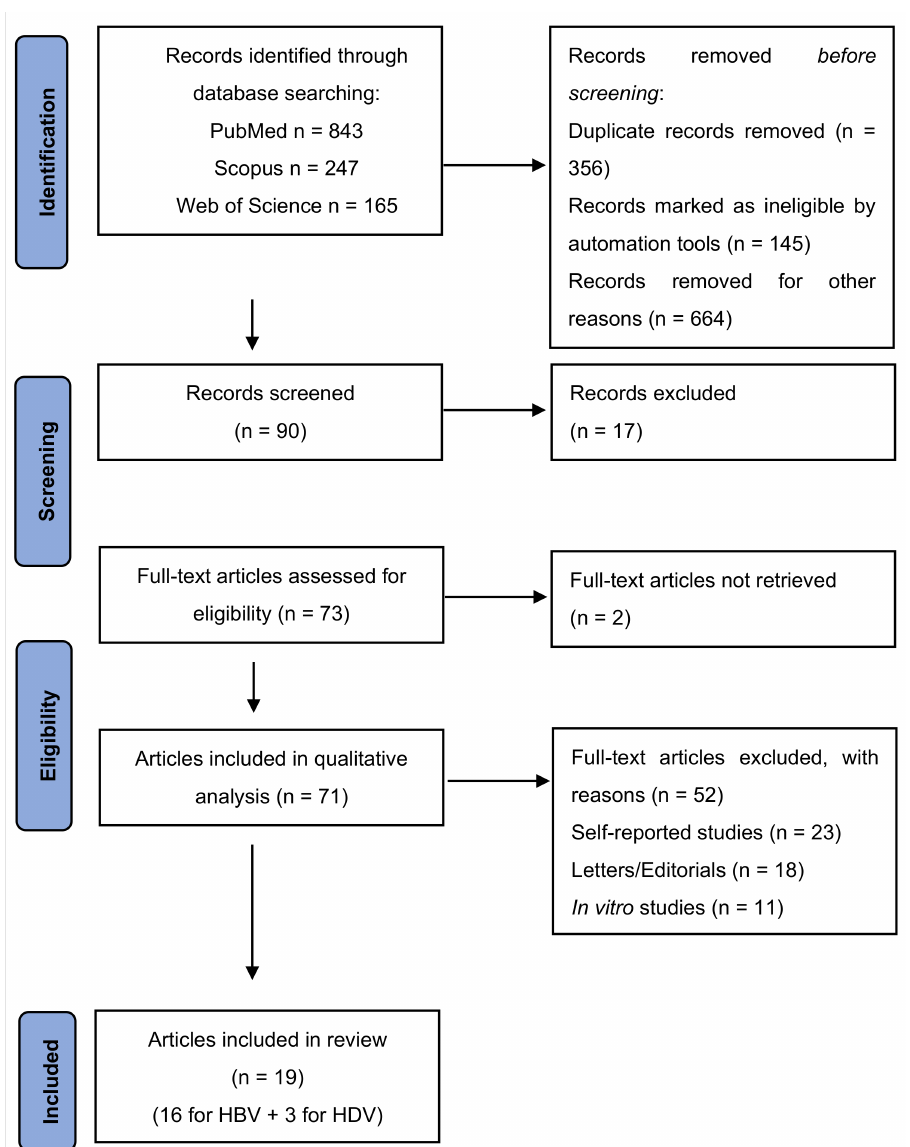
Figure 1. PRISMA flow diagram. HBV = hepatitis B virus; HDV = hepatitis D